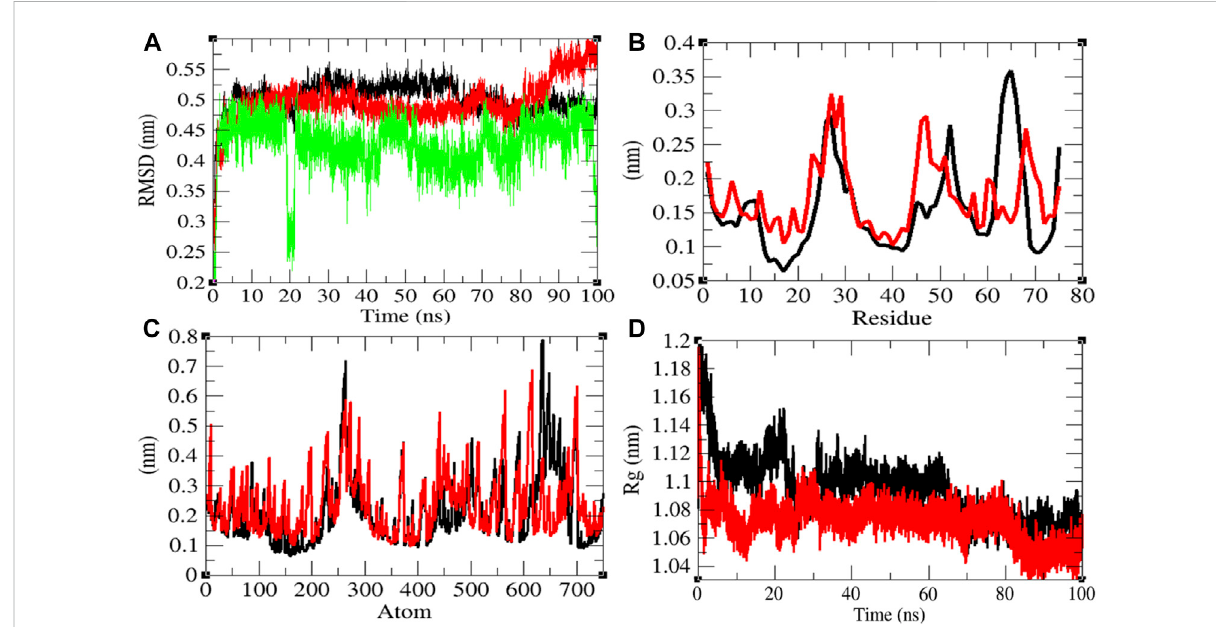
StructuraldynamicsofEprotein. (A) RootmeansquaredeviationsplotforEprotein(black),Eprotein-remdesivir(red),andremdesivir(green)asa function of time. (B) Root mean square fl uctuations vs. residues. (C) Root mean square fl uctuations vs. atoms. (D) Radius of gyration ( R g ) plot.